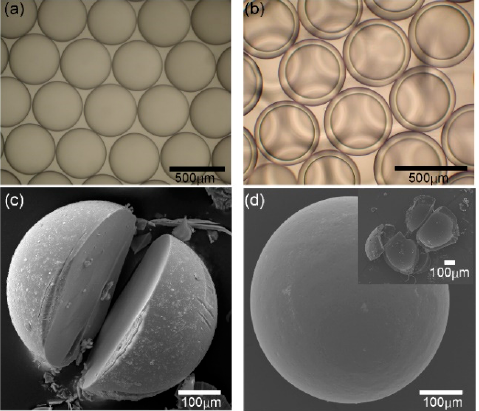
Figure 4. Calcium alginate microspheres prepared from the phase-inversion method. ( a